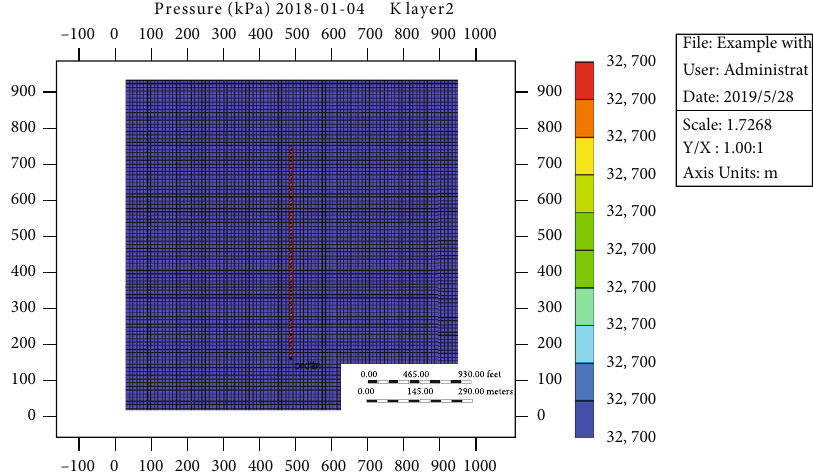
Figure 15: Establishment of the CMG digital analog model.